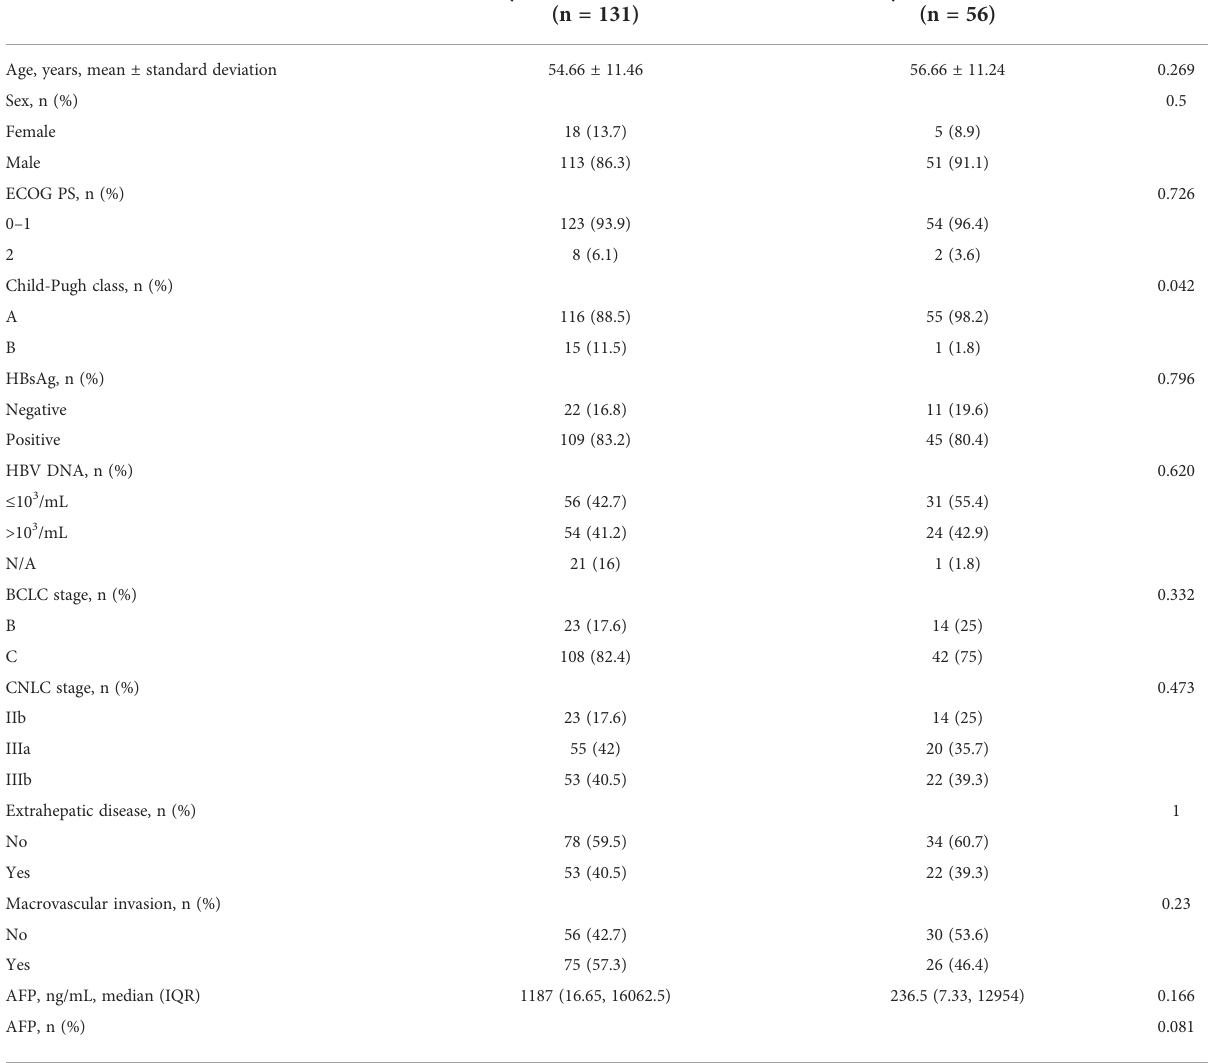
TABLE 4 Clinicopathologic features and response according to attainment of potentially resectable